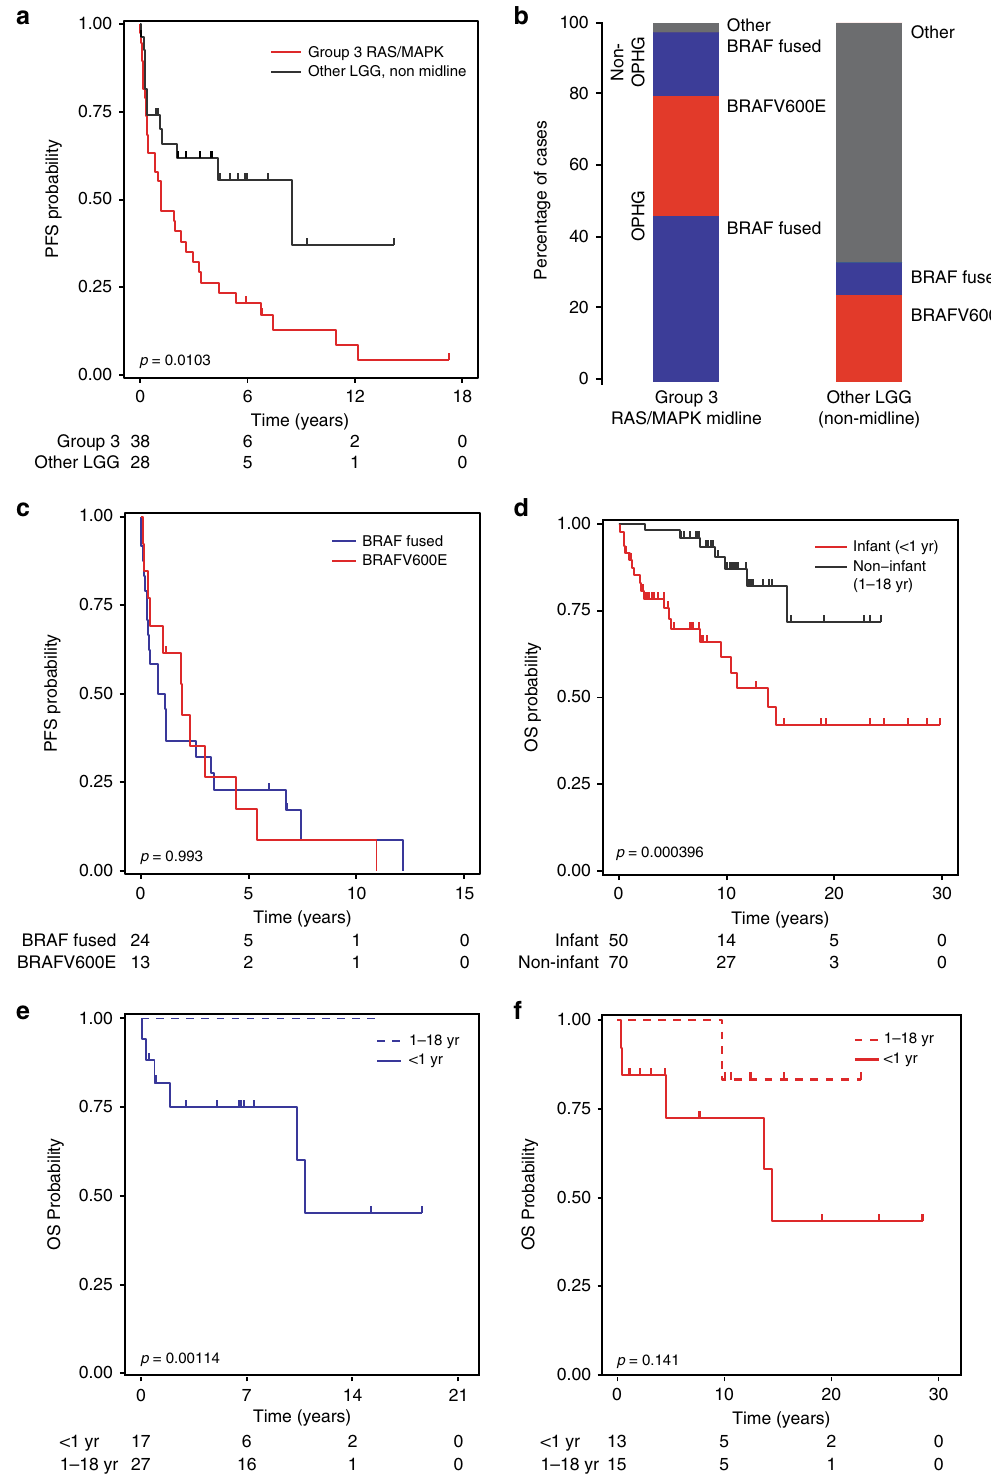
Fig. 5 Group 3 Midline RAS/MAPK tumors. a Progression-free survival (PFS) of infants with Group 3 tumors as compared with infants with other LGG (non- midline). b The molecular drivers of Group 3 as compared with other infant LGG, highlighting the enrichment for BRAF alterations in Group 3 tumors. c PFS of infant Group 3 according to BRAF status. d Overall survival (OS) of infant OPHG versus non-infant (>1 – 18 y) OPHG in SickKids cohort. Comparison of OS of BRAF Fused OPHG ( e ) and BRAFV600E mutated OPHG ( f ) in infants (Group 3 of infant cohort) vs children/adolescents aged 1 – 18 y (SickKids cohort). All p -values calculated using the log-rank test. LGG: low-grade